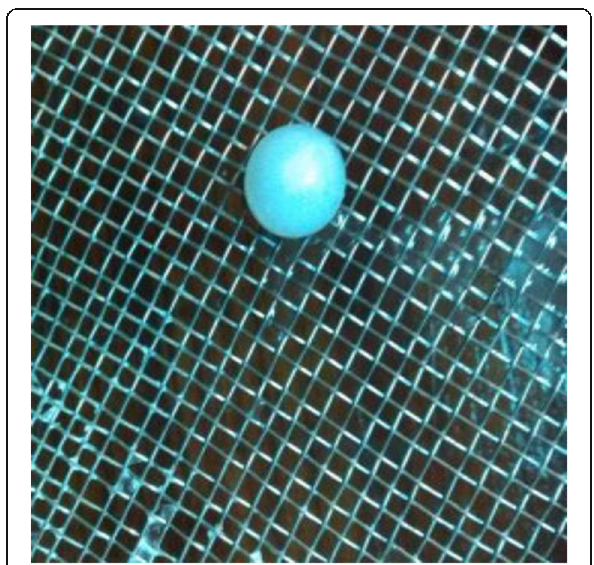
Fig. 11 Group II (cataract induced)